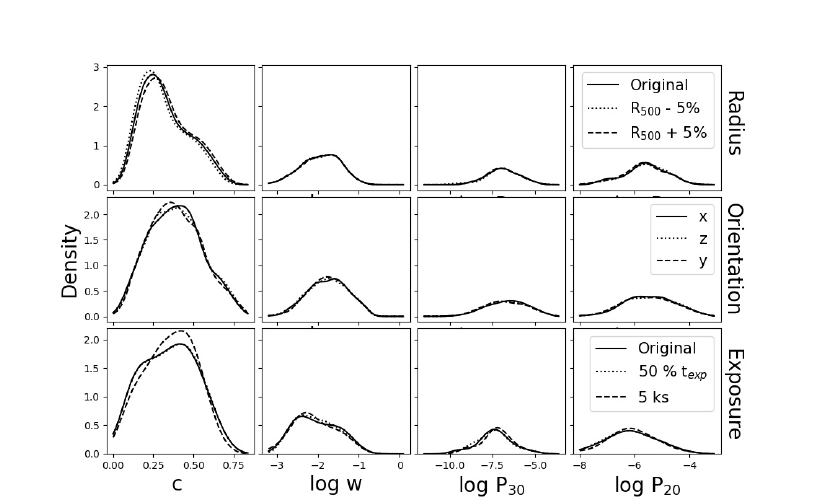
Figure 2. Results of the test reported in Section 5. Top: comparison between the morphological parameters computed in regions with di ff erent radii. Center: comparison between the morphological parameters estimated for di ff erent orientations of the same cluster. Bottom: comparison between the morphological parameters estimated from original images, images with halved exposure times and images with t exp ∼